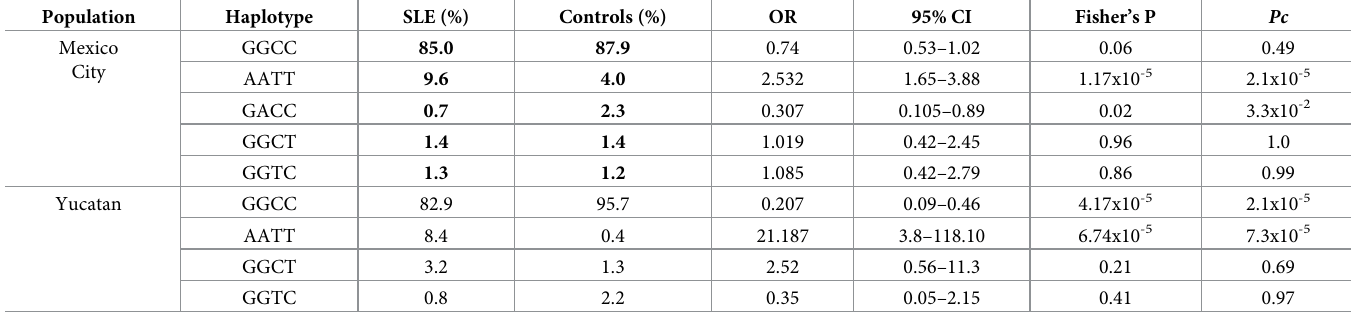
Different studies have shown that the ITGAM rs1143679G/A SNP, which changes from arginine (CGC) to histidine (CAC) at position 77 (R77H), affects the structure and function of this protein, and that the ITGAM rs1143679A allele has been associated with transcript and Table 4. ITGAM haplotype frequencies and association analysis in patients with SLE and controls from Mexico City and Yucatan. The order of the SNPs is: rs34572943-rs1143679-rs9888739-rs1143683. Population Mexico